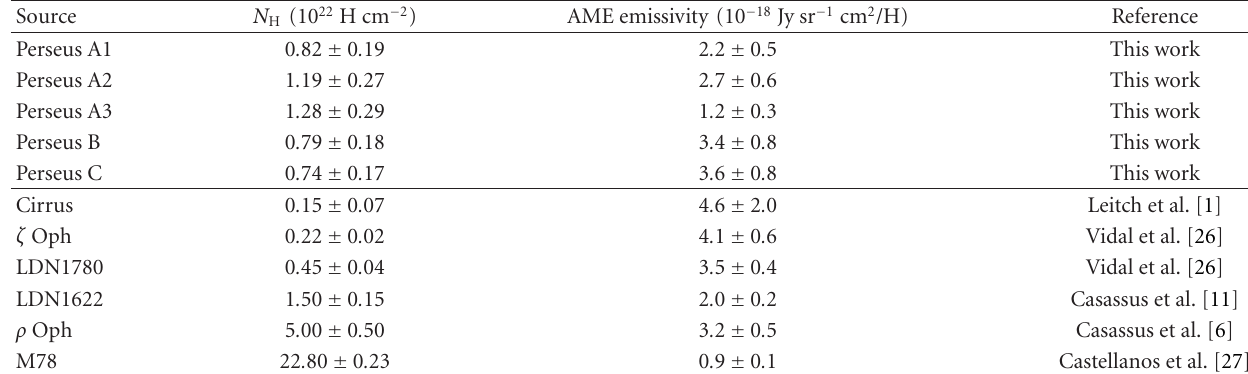
Table 2: AME emissivity values for a variety of phases of the ISM computed relative to the hydrogen column density.